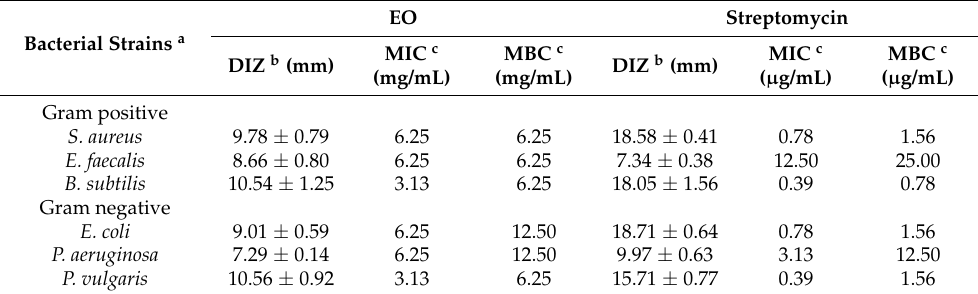
Table 2. Antibacterial activity of R. beesianus rhizome